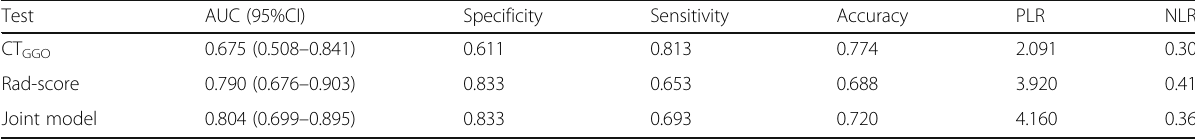
Table 3 ROC analysis for three